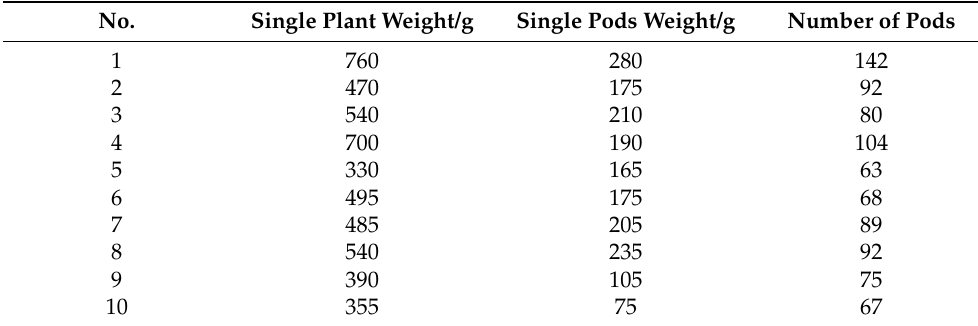
Table 3. Statistics of peanut plant